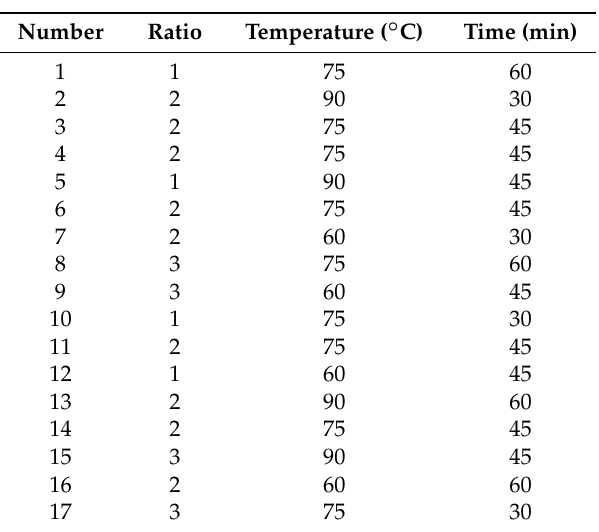
Table 2. Response surface optimization